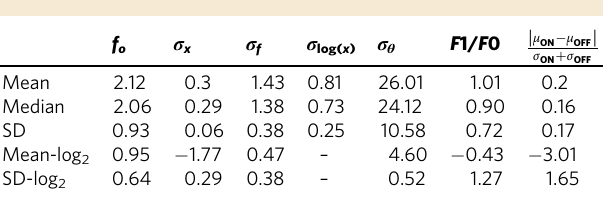
Table 1 Marginal statistics.